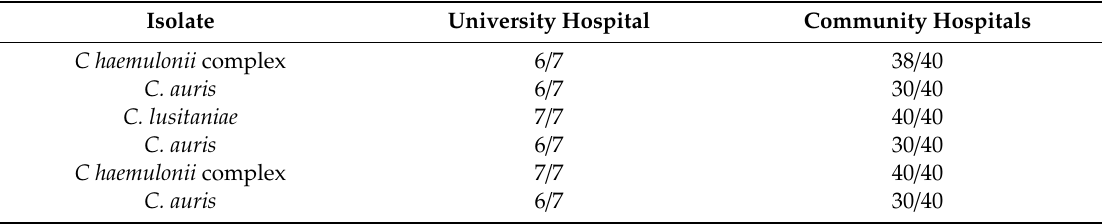
Table 2. Identification of C. auris, C. haemulonii complex, and C. lusitatiae by university and community hospitals.